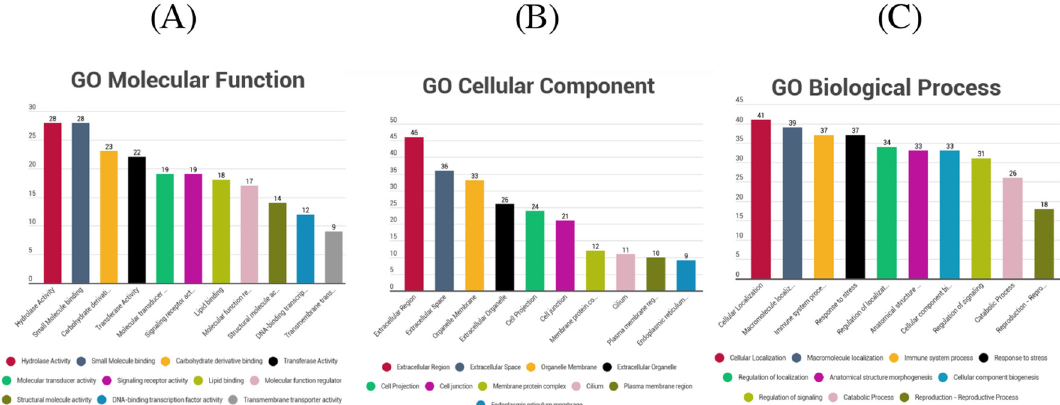
Figure 3. Grouping of genes on which the prioritized variants were found according to GO terms for Molecular Function ( A ), GO terms for Cellular Component ( B ), and GO terms for Biological Process ( C ). The horizontal axis represents the GO terms and the vertical axis the number of genes that were found to be annotated on every GO term.